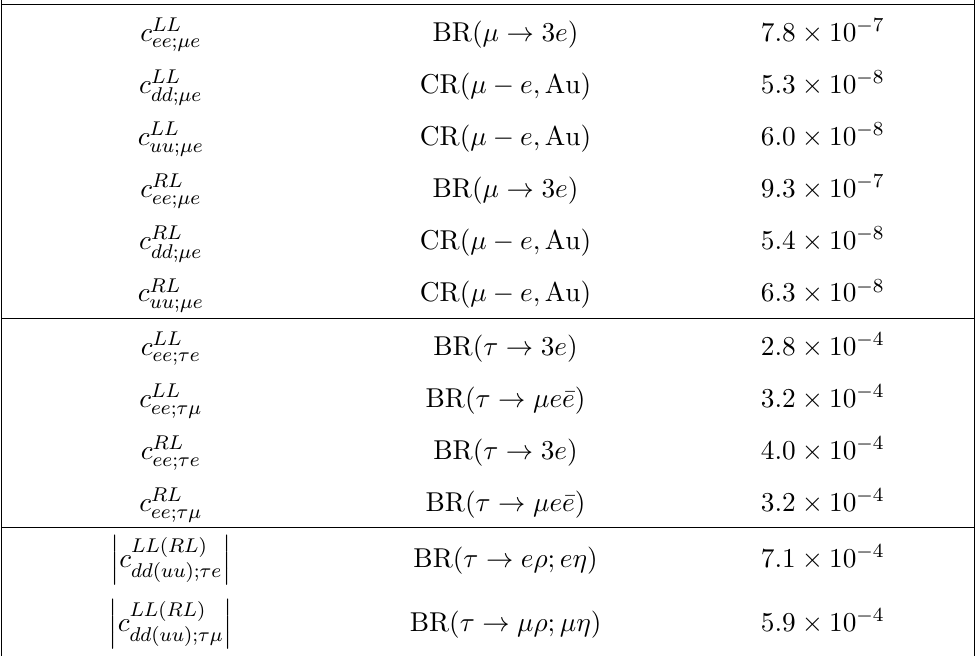
Table 1 . Experimental sensitivities of various relevant (cid:23) LEFT Wilson coe(cid:14)cients in eq. (2.3) [120] based on the current best limits from various cLFV experiments. To derive the bottom two con- straints it has been assumed that LFV is induced either on left-handed or right-handed quarks, but not both